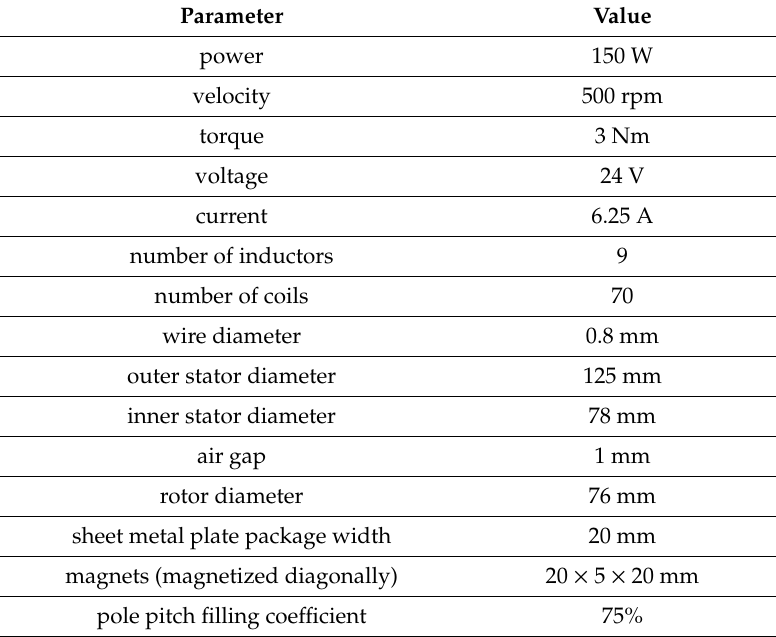
Table 2. List of parameters of the DCPM motors being tested.